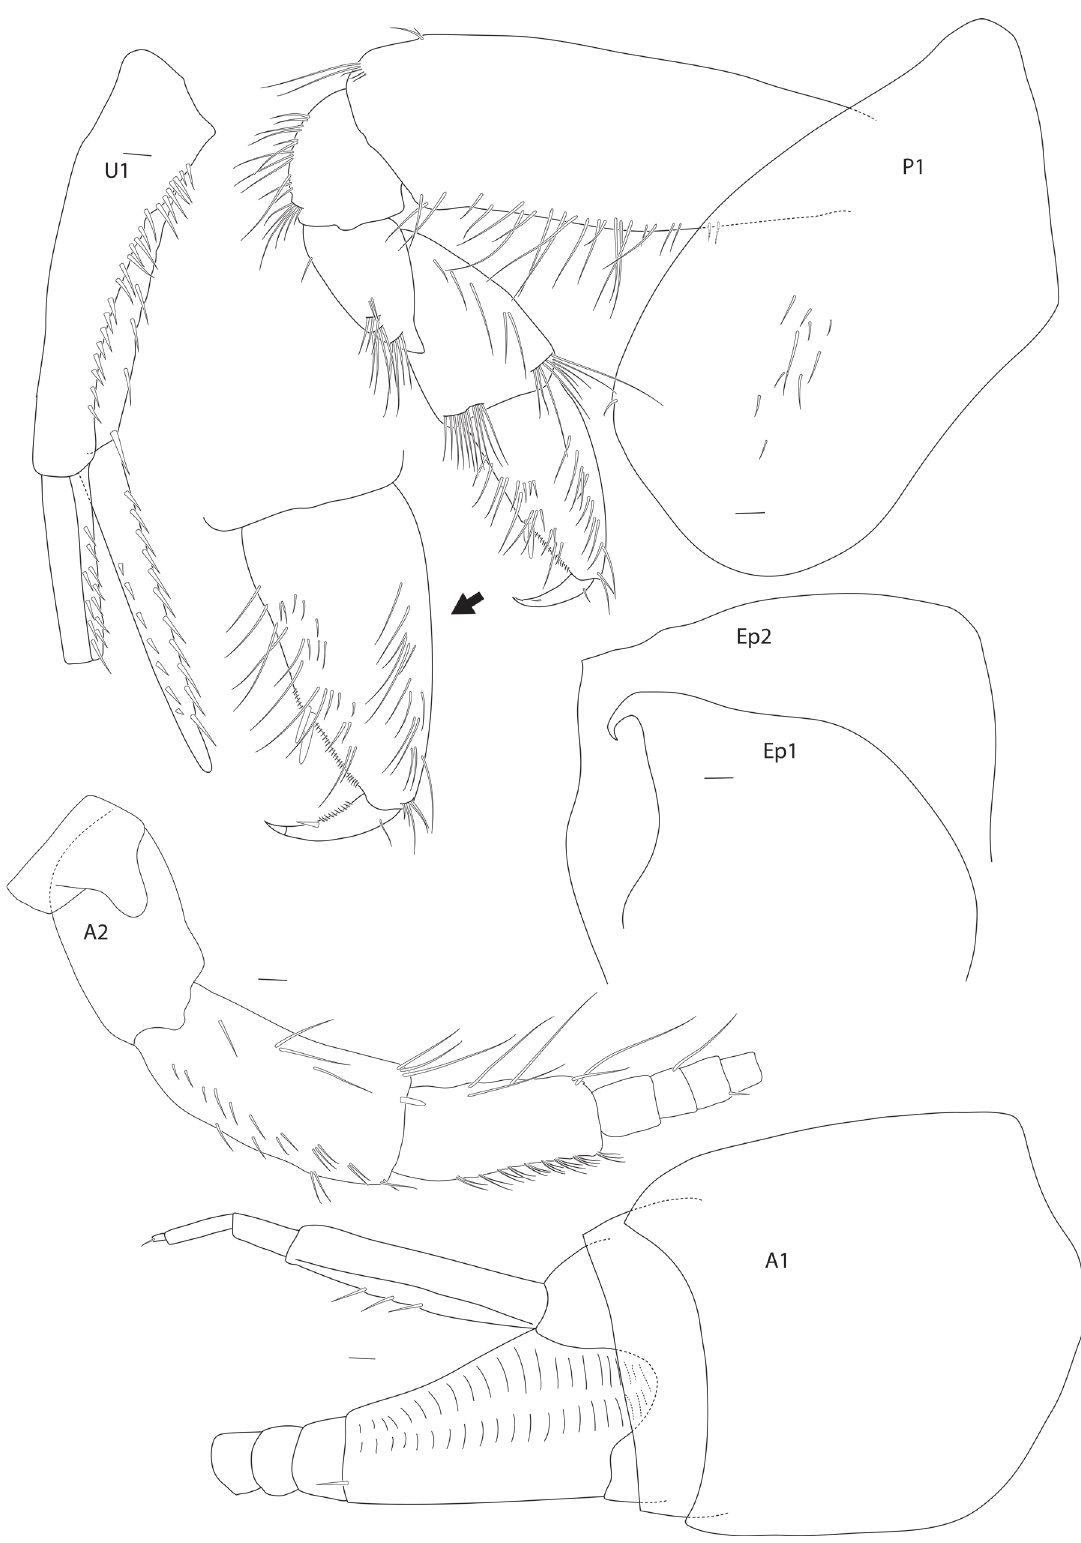
Fig. 4. Onisimus turgidus (Sars, 1879), syntype, ♀, 15 mm, Barents Sea (F1764). Antenna 1–2, pereopod 1, epimeral plates 1–2, uropod 1. Abbreviations: see Material and methods. Scale bars = 0.1